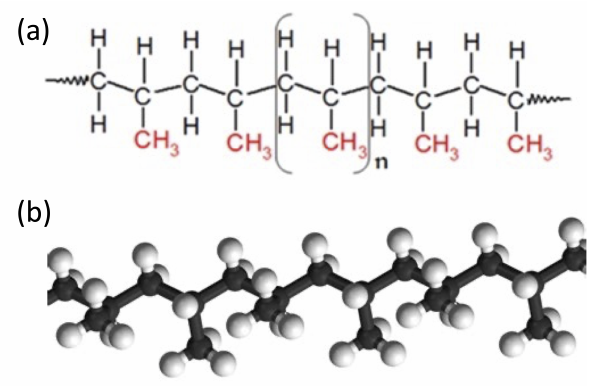
Figure 1. Structure of polypropylene molecular chain ( a ) and its three-dimensional graphical recon- struction ( b